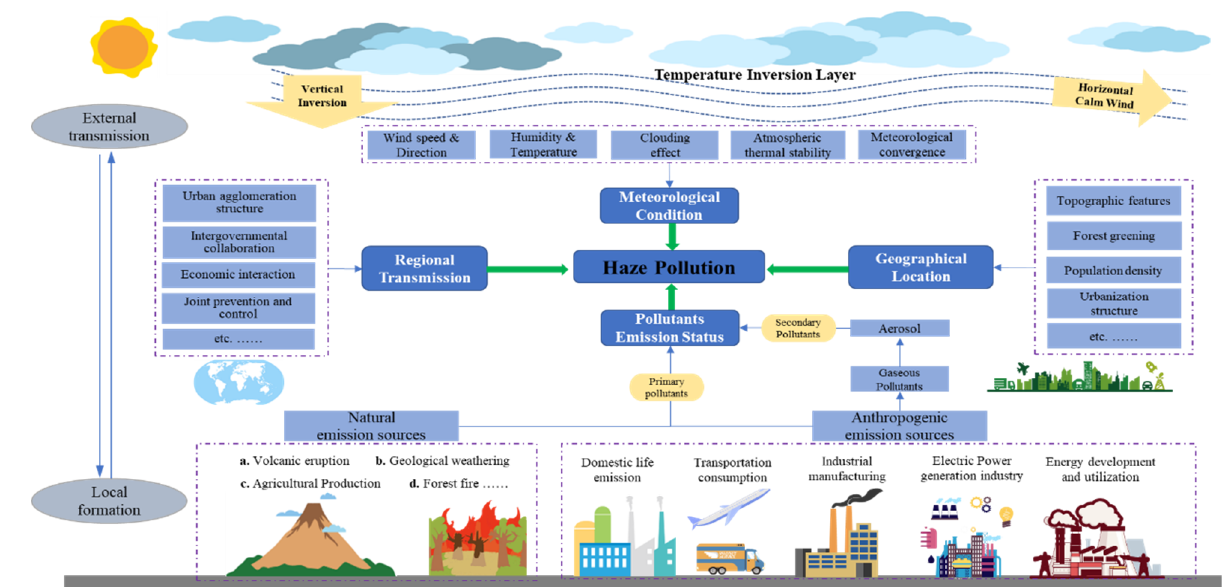
Figure 3. A scenario analysis of the mechanisms of the formation of regional haze pollution.